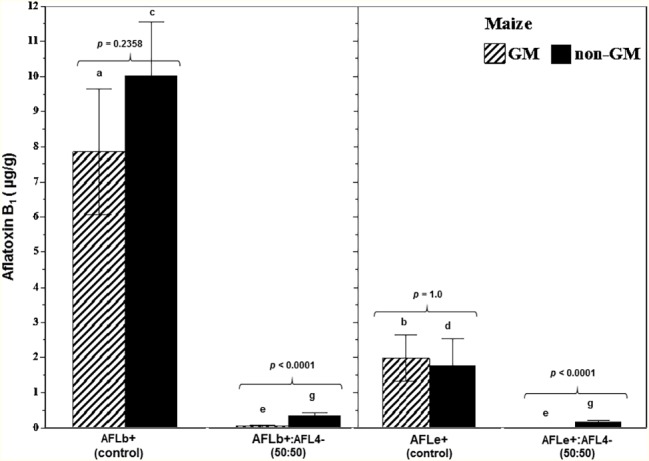
Overall aflatoxin B1 contamination of post-harvest stored maize grain treated with a mixture of a non-toxigenic and a toxigenic strain of A. flavus in non-GM and GM maize cultivars taking into account the parameters of water availability (0.98, 0.95), time of incubation (10, 20 days), and type of maize cultivar (non-GM vs. GM). The grain was inoculated with two different Brazilian or NRRL type toxigenic strains (AFL+ or AFLe+) and the non-toxigenic Brazilian strain AFL4− in a 50:50 inoculum ratio. Different letters indicate a significant difference (p < 0.05) between the strains of the same maize type. The values of p show differences in overall AFB1 content comparing GM and non-GM maize at 5% significance. Bars represent mean ± SE.